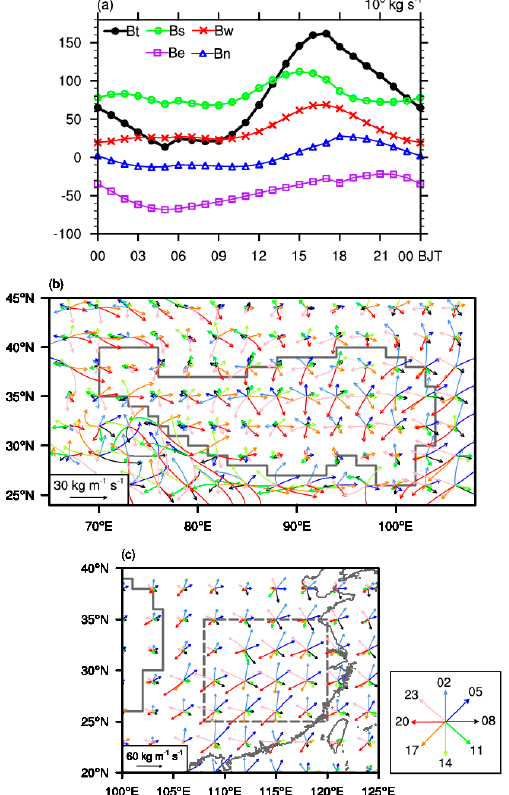
Figure 3. ( a ) Diurnal cycles of the net water vapor budget (Bt; black curve) and water vapor budgets at the southern (Bs; green curve), western (Bw; red curve), northern (Bn; blue curve), and eastern (Be; purple curve) boundaries over the TP during summer (unit: 10 6 kg s − 1 ). ( b ) Diurnal variation in vertically integrated water vapor fluxes around the TP in summer (unit: kg m − 1 s − 1 ). The daily mean has been removed in each grid. The gray contour in ( b ) indicates the TP area ( ≥ 2000 m). ( c ) is the same as in ( b ), but over eastern